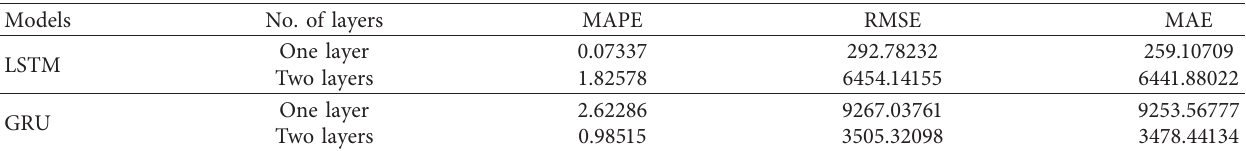
Table 7: The results of DL for the confirmed cases in Saudi